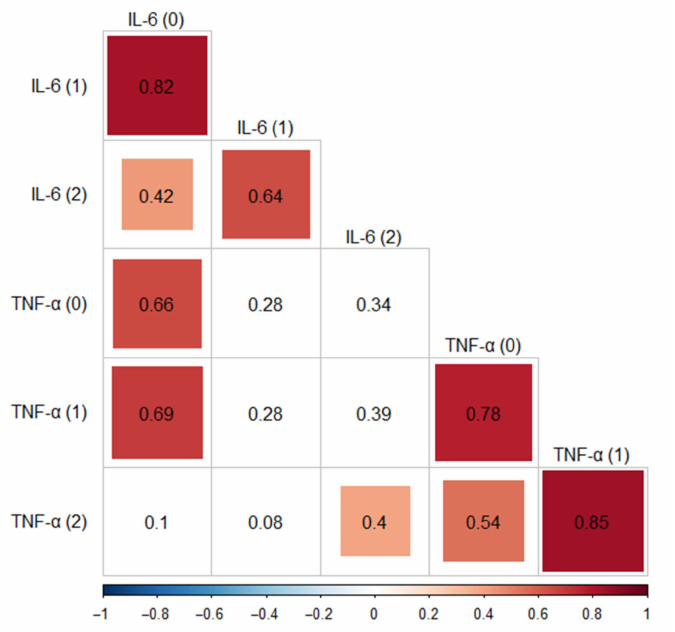
Figure 1. Correlations between biomarkers. Statistically, significant links are marked in colour (correlation values are entered in tiles).